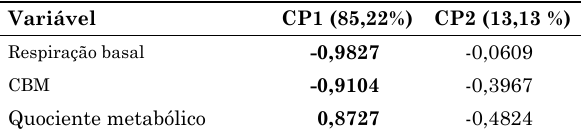
Quadro 6. correlação entre respiração basal, carbono da biomassa microbiana (cbm), quociente metabólico e dois componentes